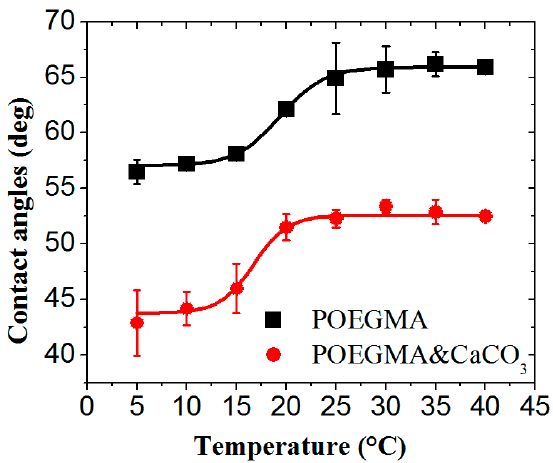
Figure 6. Temperature dependence of the water contact angle determined for the POEG- MA-grafted brush coatings and the POEGMA-grafted brush coatings with embedded CaCO 3